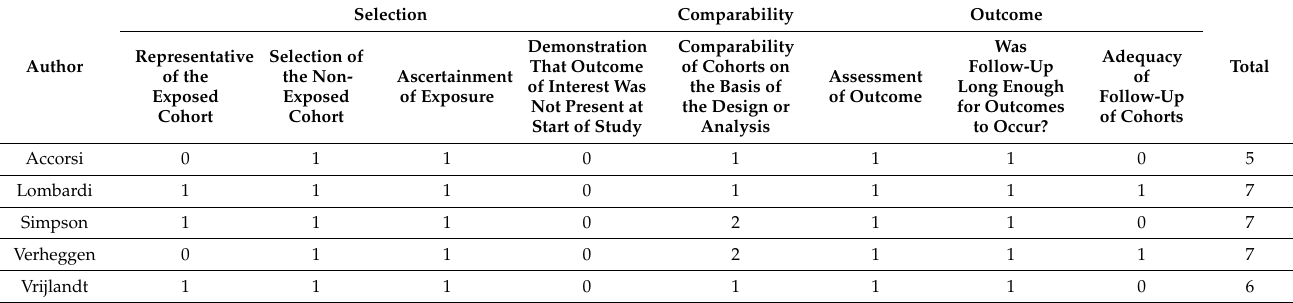
Table 2. Risk of bias evaluation—Newcastle–Ottawa Scale